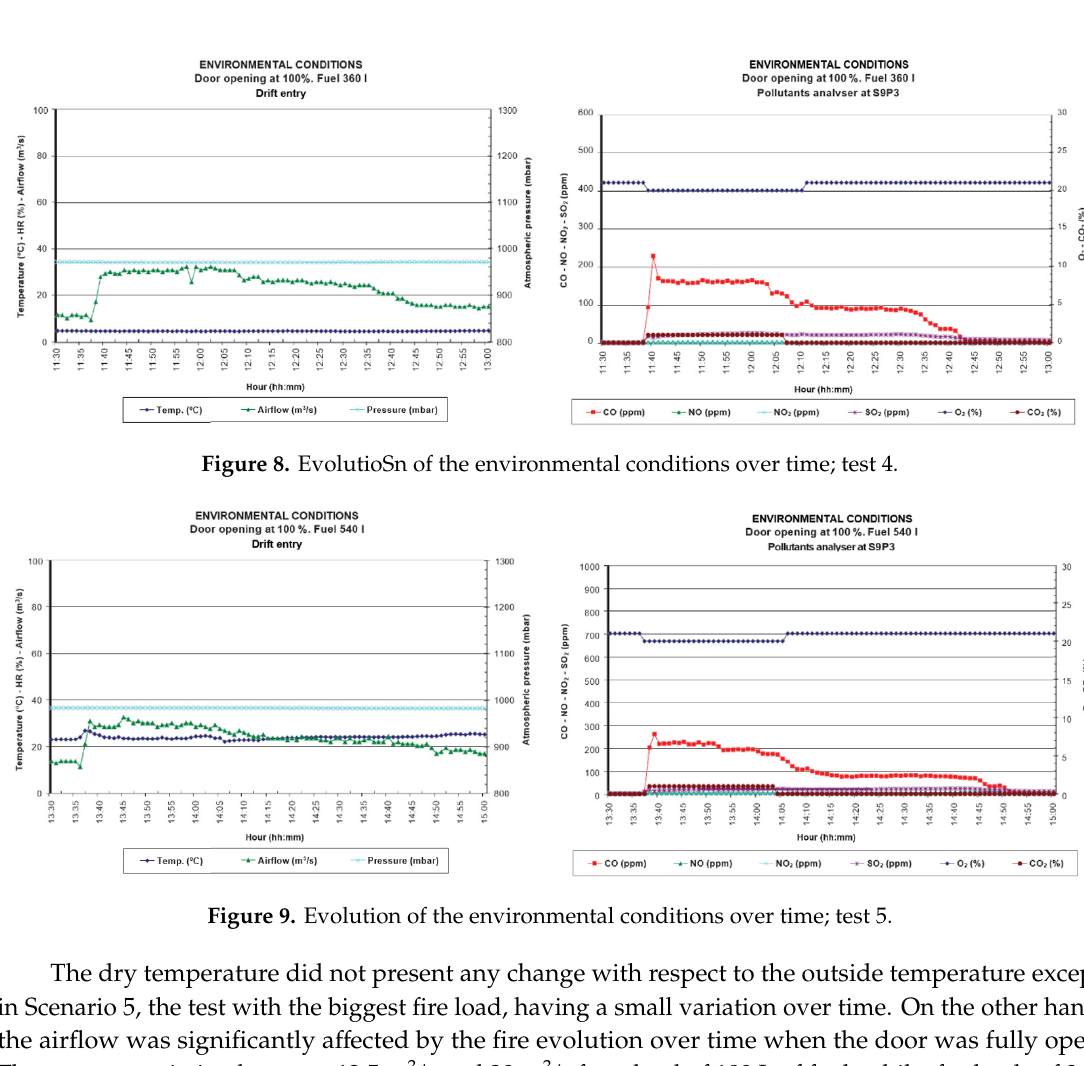
Figure 7. Evolution of the environmental conditions over time; test 3.